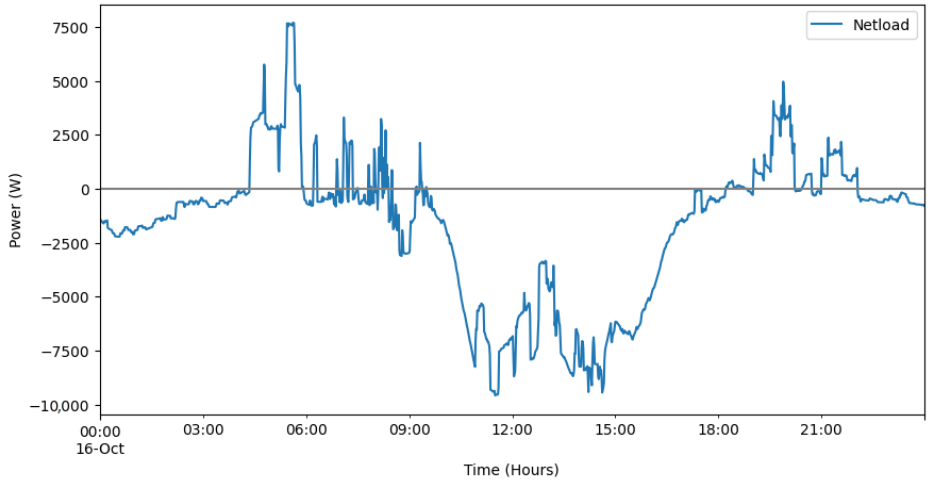
Figure 7. First day of the community netload profile.